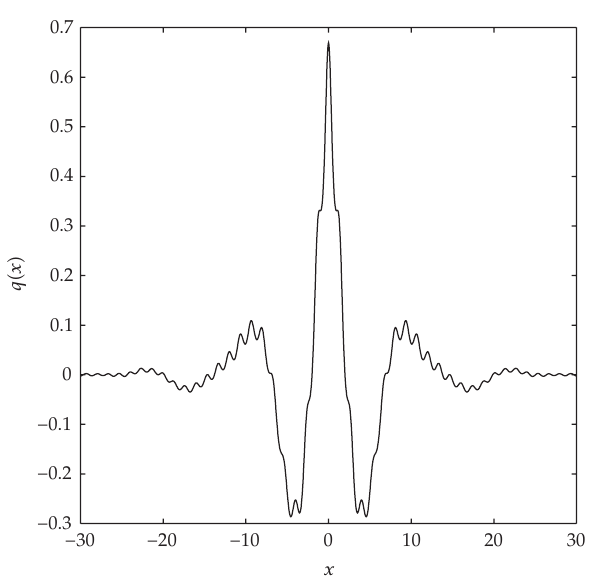
Figure 2: Example 5.1: Estimated kernel function q (cid:2) x (cid:3)